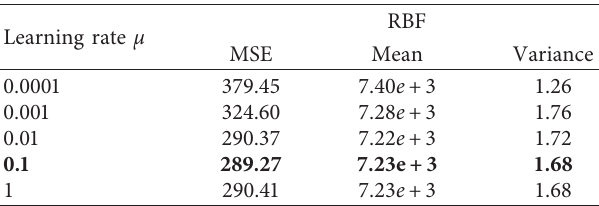
Table 6: Variation of MSE, output power mean, and variance with the learning rate μ .